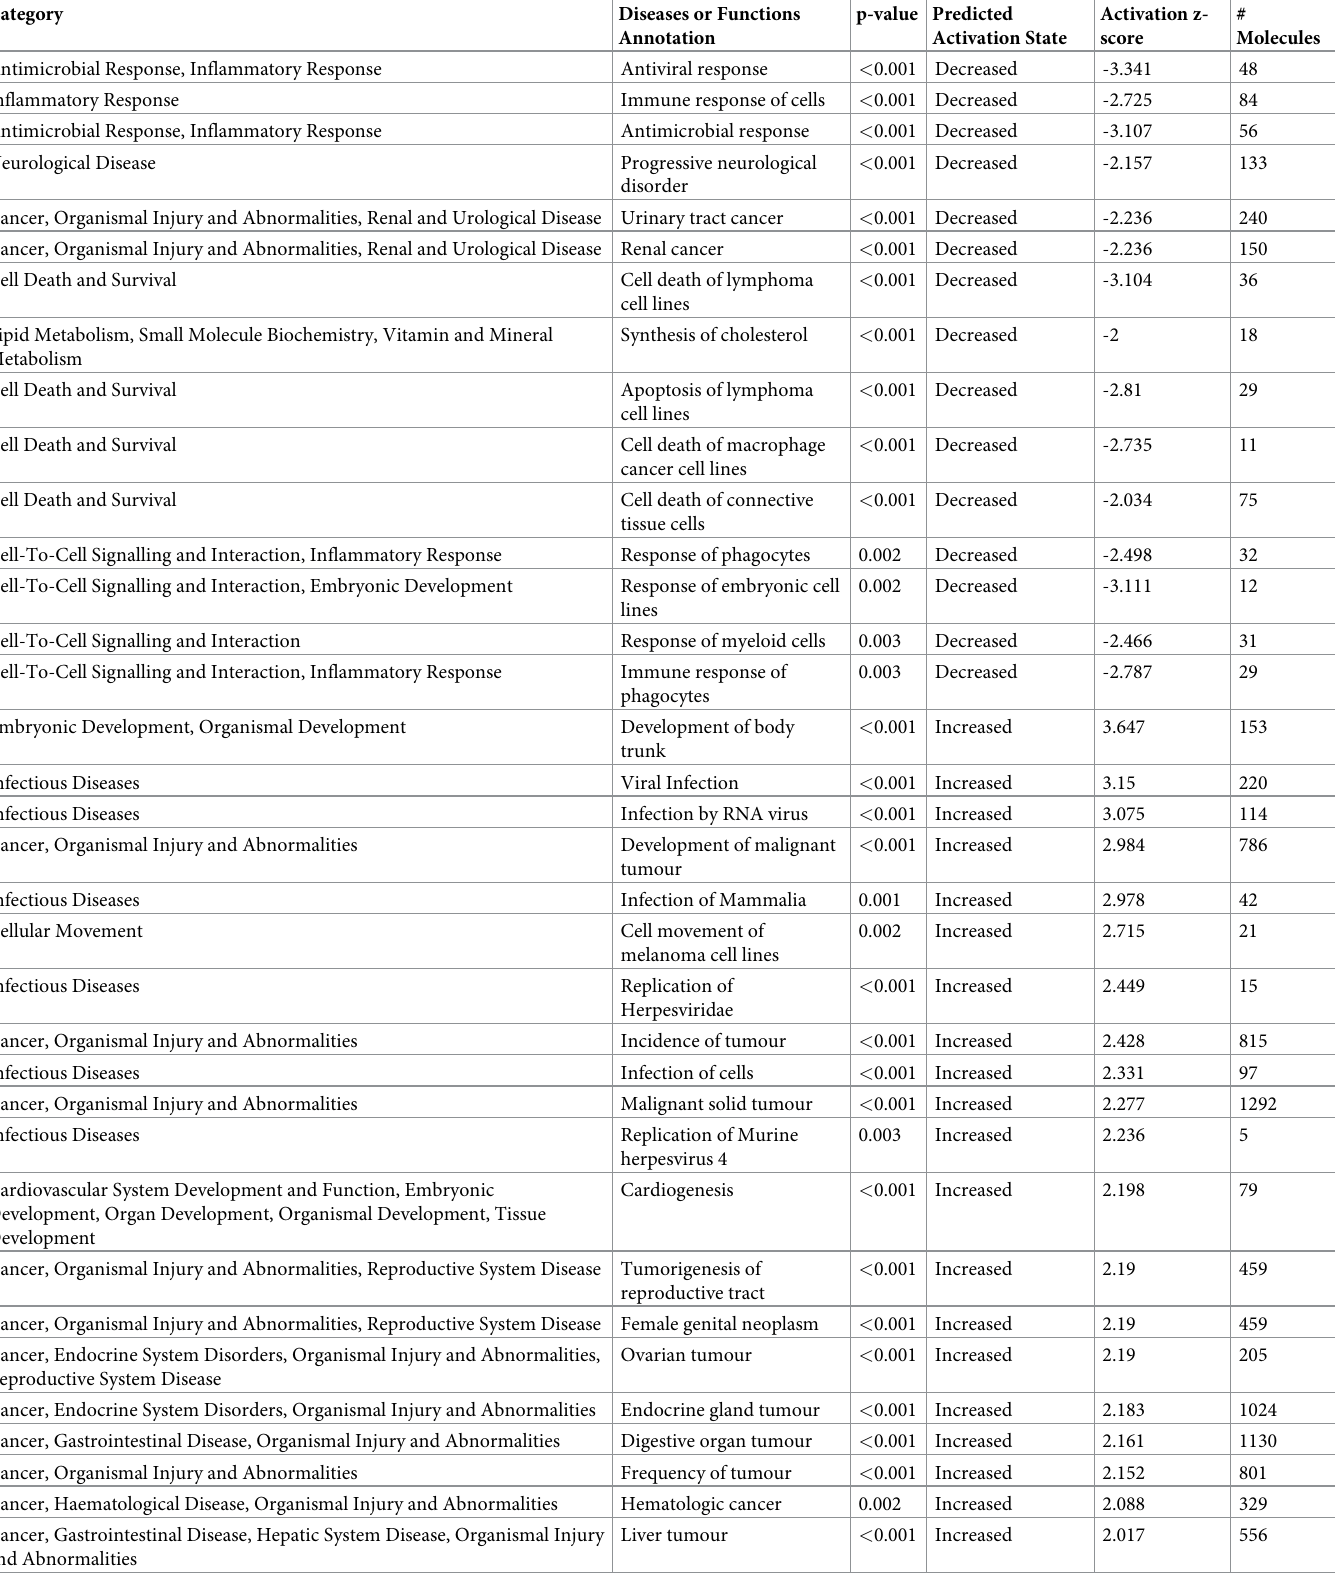
Table 2. IPA for disease pathways and functions enriched in data set of differentially expressed genes between Holstein and Sahiwal T . annulata infected cell lines.